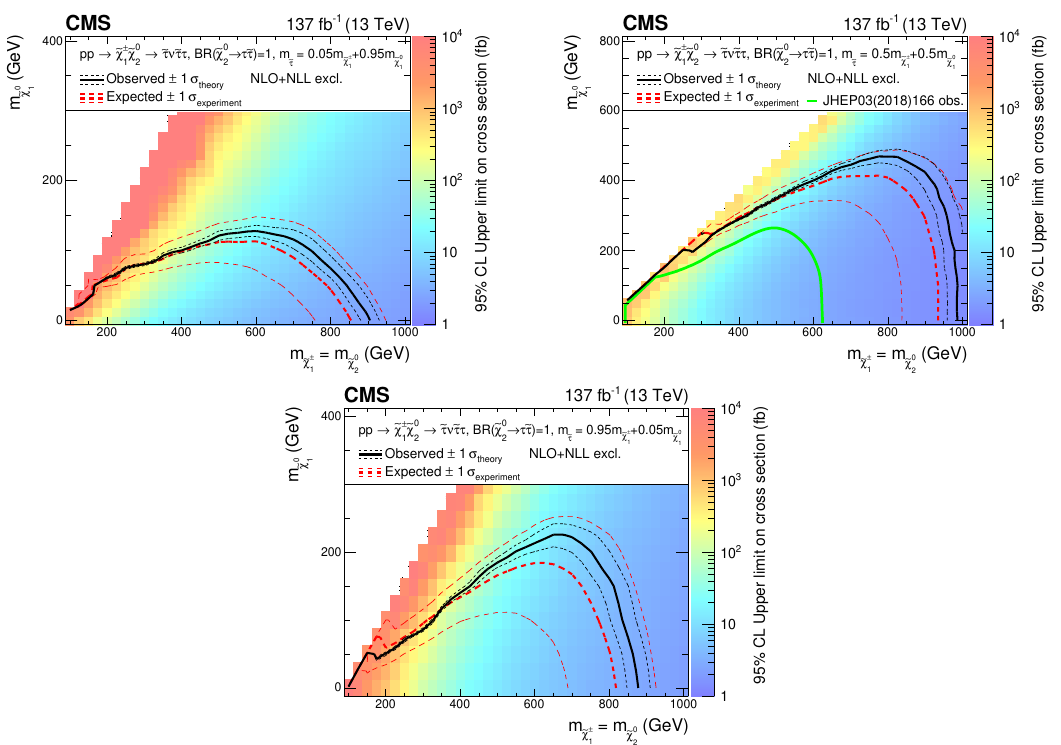
0 production with τ -dominated slepton-mediated Figure 18 . Interpretation of the results for e c ± 2 1 e c decays, and the parameter governing the mass splittings being x = 0 . 05 (upper left), x = 0 . 5 (upper right) and x = 0 . 95 (lower). The shading in the m versus m plane indicates the 95% CL upper 0 0 e c e c 1 2 ± 0 limits on the production cross sections. The contours delineate the mass regions excluded e c 2 1 e c at 95% CL when assuming cross sections computed at NLO plus NLL. The observed, observed ( ± 1 standard deviation of the theoretical cross sections), median expected, and expected ± 1 σ theory bounds are shown in black and red. The median expected bound obtained with the ± 1 σ experiment search region strategy is shown in blue. The observed limits obtained in the CMS analysis using 2016 data [20] are shown in green, which only included interpretations in the x = 0 . 5